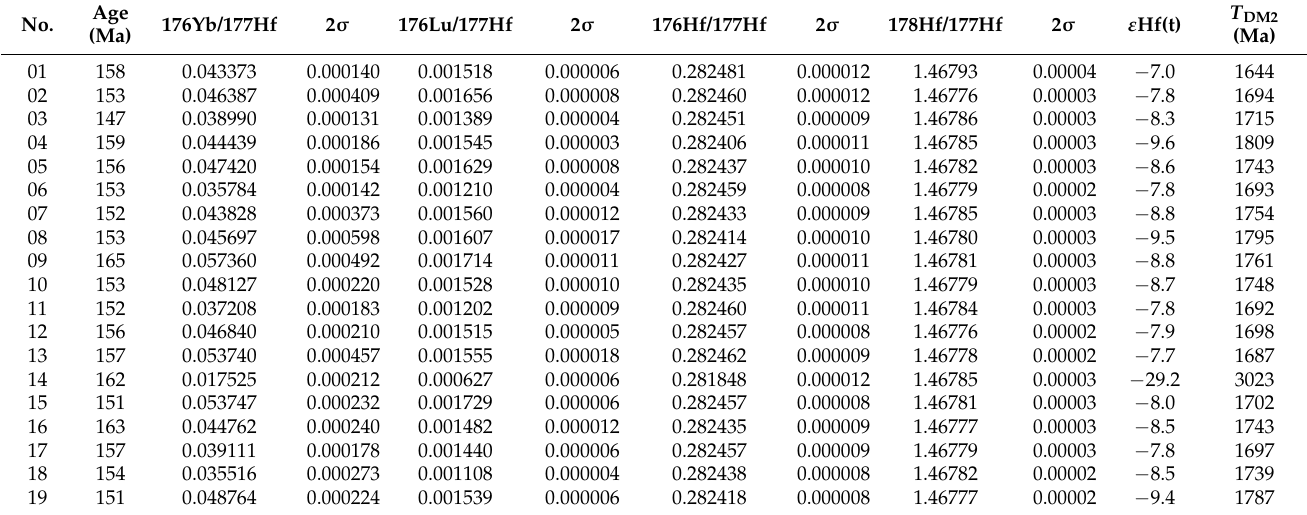
Table 6. The Hf isotopic compositions of zircons from No. 3 granodiorite in Shuikoushan